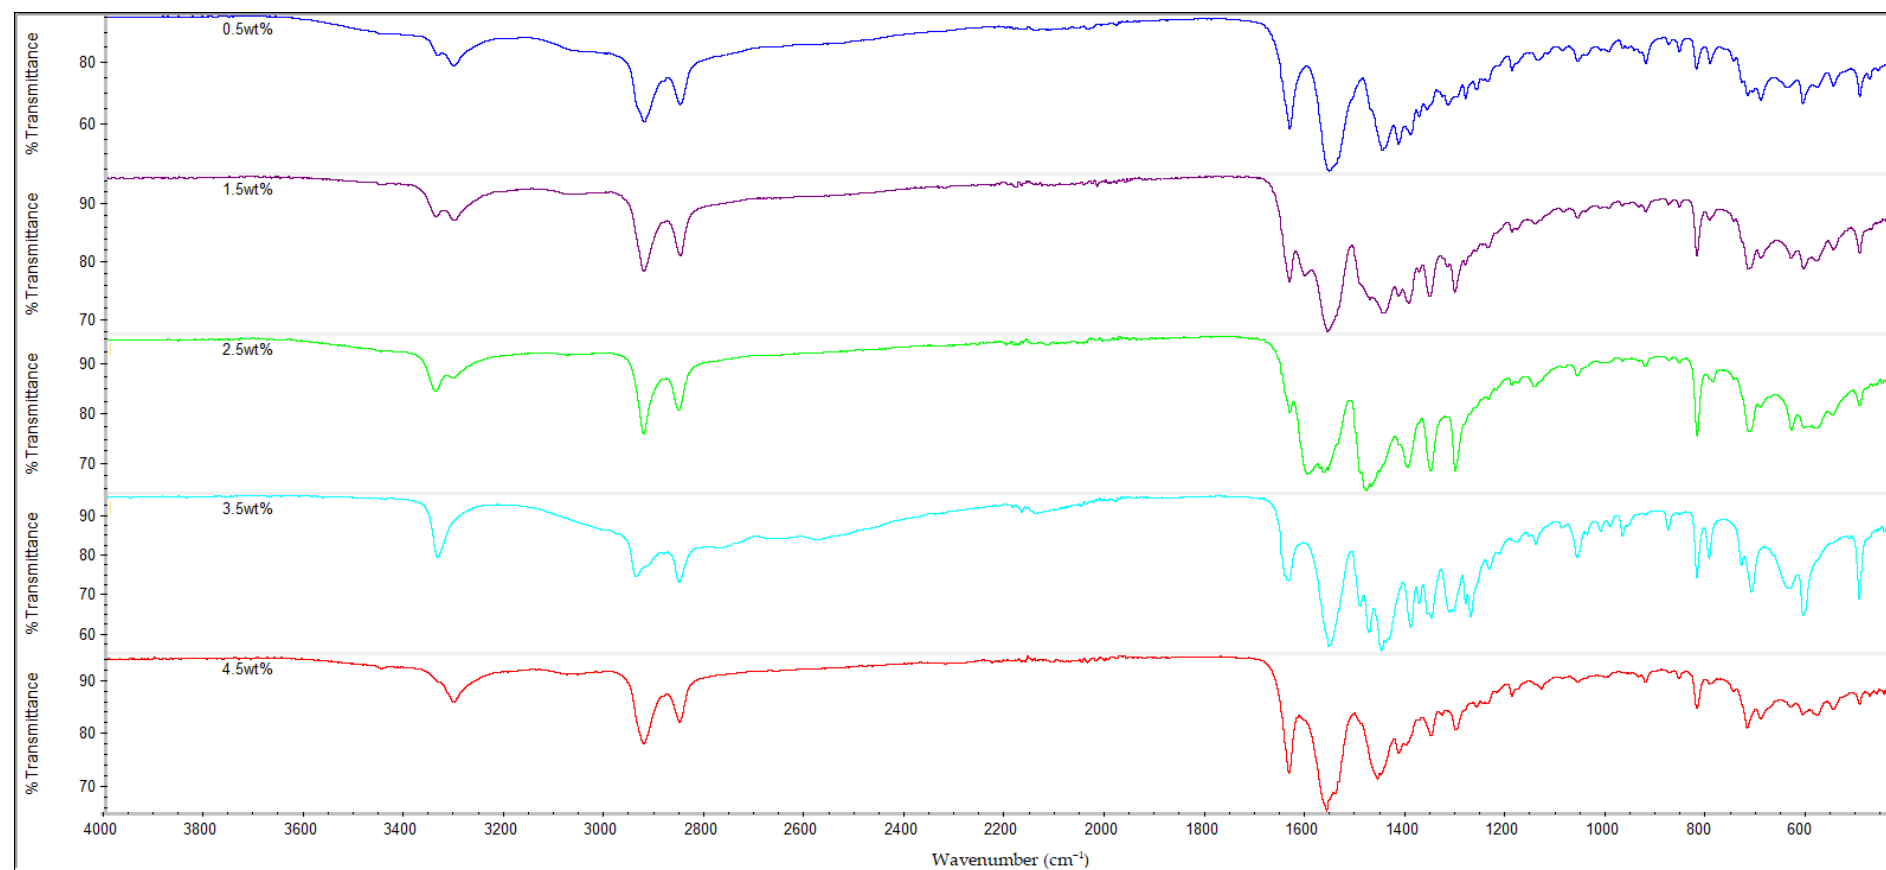
Figure 12. FTIR Spectra for Nylon 610 Nanocomposites with Graphite Nanosheets Treated at 150 °C and − 0.1 MPa.